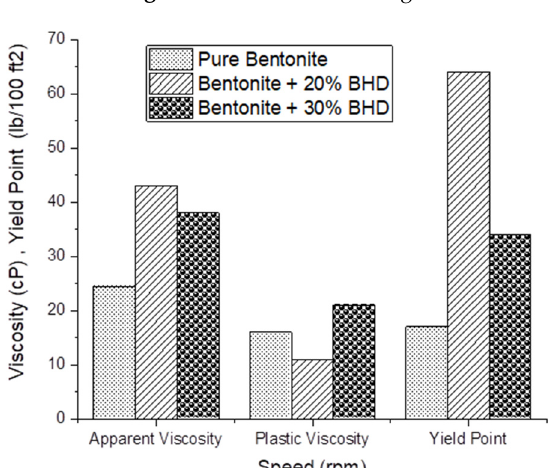
Figure 9. Viscometer readings.